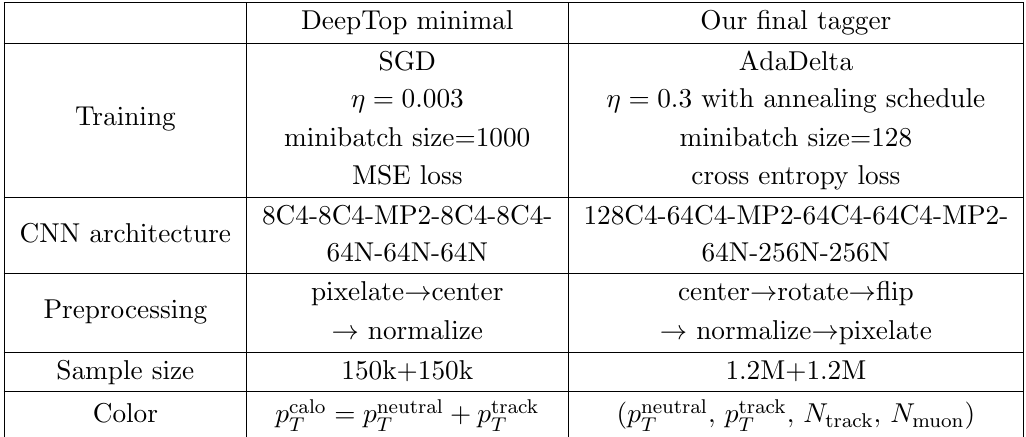
Table 2 . Summary of our (cid:12)nal CNN tagger, together with the original DeepTop tagger.